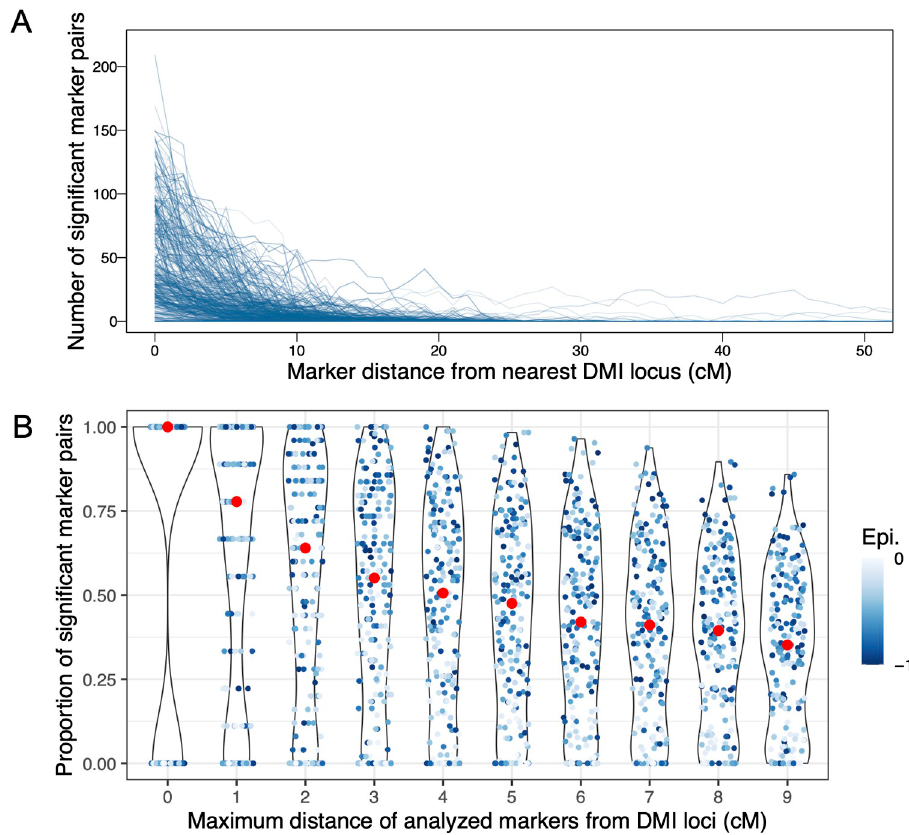
Fig 7. Propagation of the DMI signal into flanking regions in simulated data (sampled at generation 30, significance threshold: X (2) < − 0.005 & D ’ < 0). Data resulted from 100 simulations using SLiM, in which two DMIs (i.e., four DMI loci) were randomly distributed on four chromosomes, thus resulting in inter- and intrachromosomal DMIs. The direct selection coefficients α and β were drawn from an exponential distribution with mean 0.001. The strength of epistasis was drawn from a uniform distribution, γ 2 [-1, -0.001], which is represented by the blue color intensity in both panels. To resemble the demography of the studied hybrid swordtail fish populations, the admixture proportion was set to f = 0.3 and the migration rate was m = 0.01. Two hundred individuals were sampled from each simulation to obtain the statistics. A. The number of significant marker pairs decreases rapidly with distance to the nearest true DMI locus. B. Proportion of significant marker pairs when statistics were computed for all pairs between two increasingly large regions around the true interacting DMI loci. Red dots indicate the median obtained from 100 simulations. Both weak and strong DMIs can be detected, but weak DMIs tend to leave a weaker signal that did not extend as far as the signal of strong DMIs.